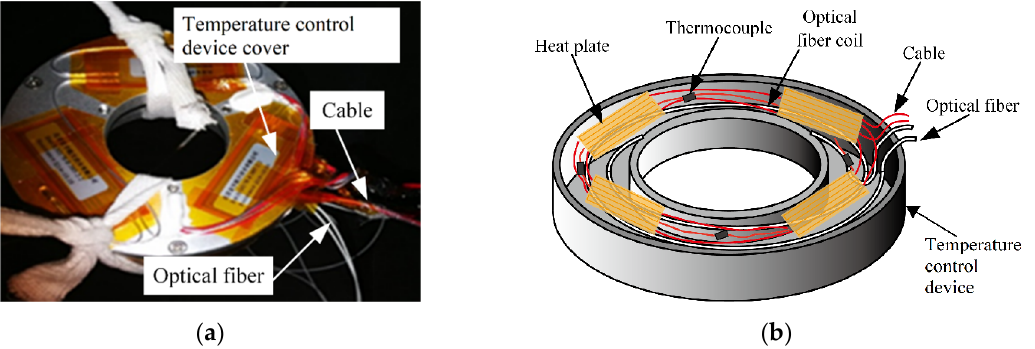
Figure 6. ( a ) Picture of the temperature control device; ( b ) the inside of the temperature control device.